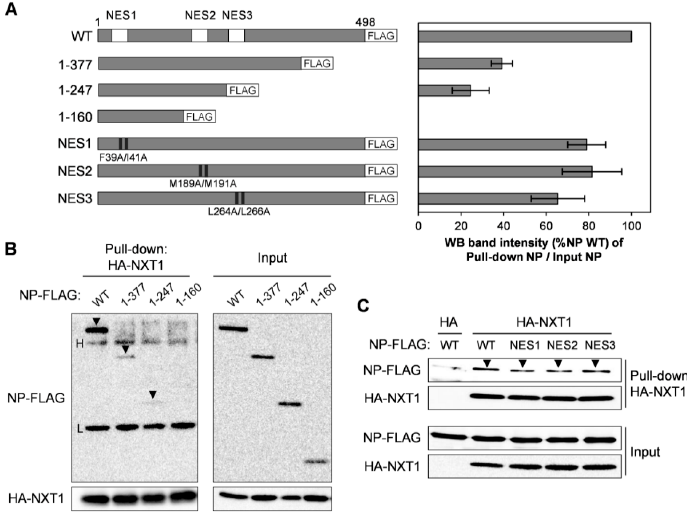
(WT), the N-terminal partial constructs, and the NES domain mutants. Right panel shows intensity (% NP WT) of the pull-down NP band divided by the input NP band from the WB analysis of ( B , C ). Data shown are the results from two independent experiments (error bars) and the mean values; ( B , C ) HA-NXT1 protein was immobilized on anti-HA agarose beads and co-incubated overnight with purified N-terminal NP-FLAG ( B ) or NES mutant NP-FLAG ( C ). The beads were collected, washed, and subjected to WB analysis with anti-FLAG and anti-HA antibodies. Black arrowheads indicate binding of NXT1 and NP. H and L indicate the heavy and light chains of the agarose-conjugated anti-HA